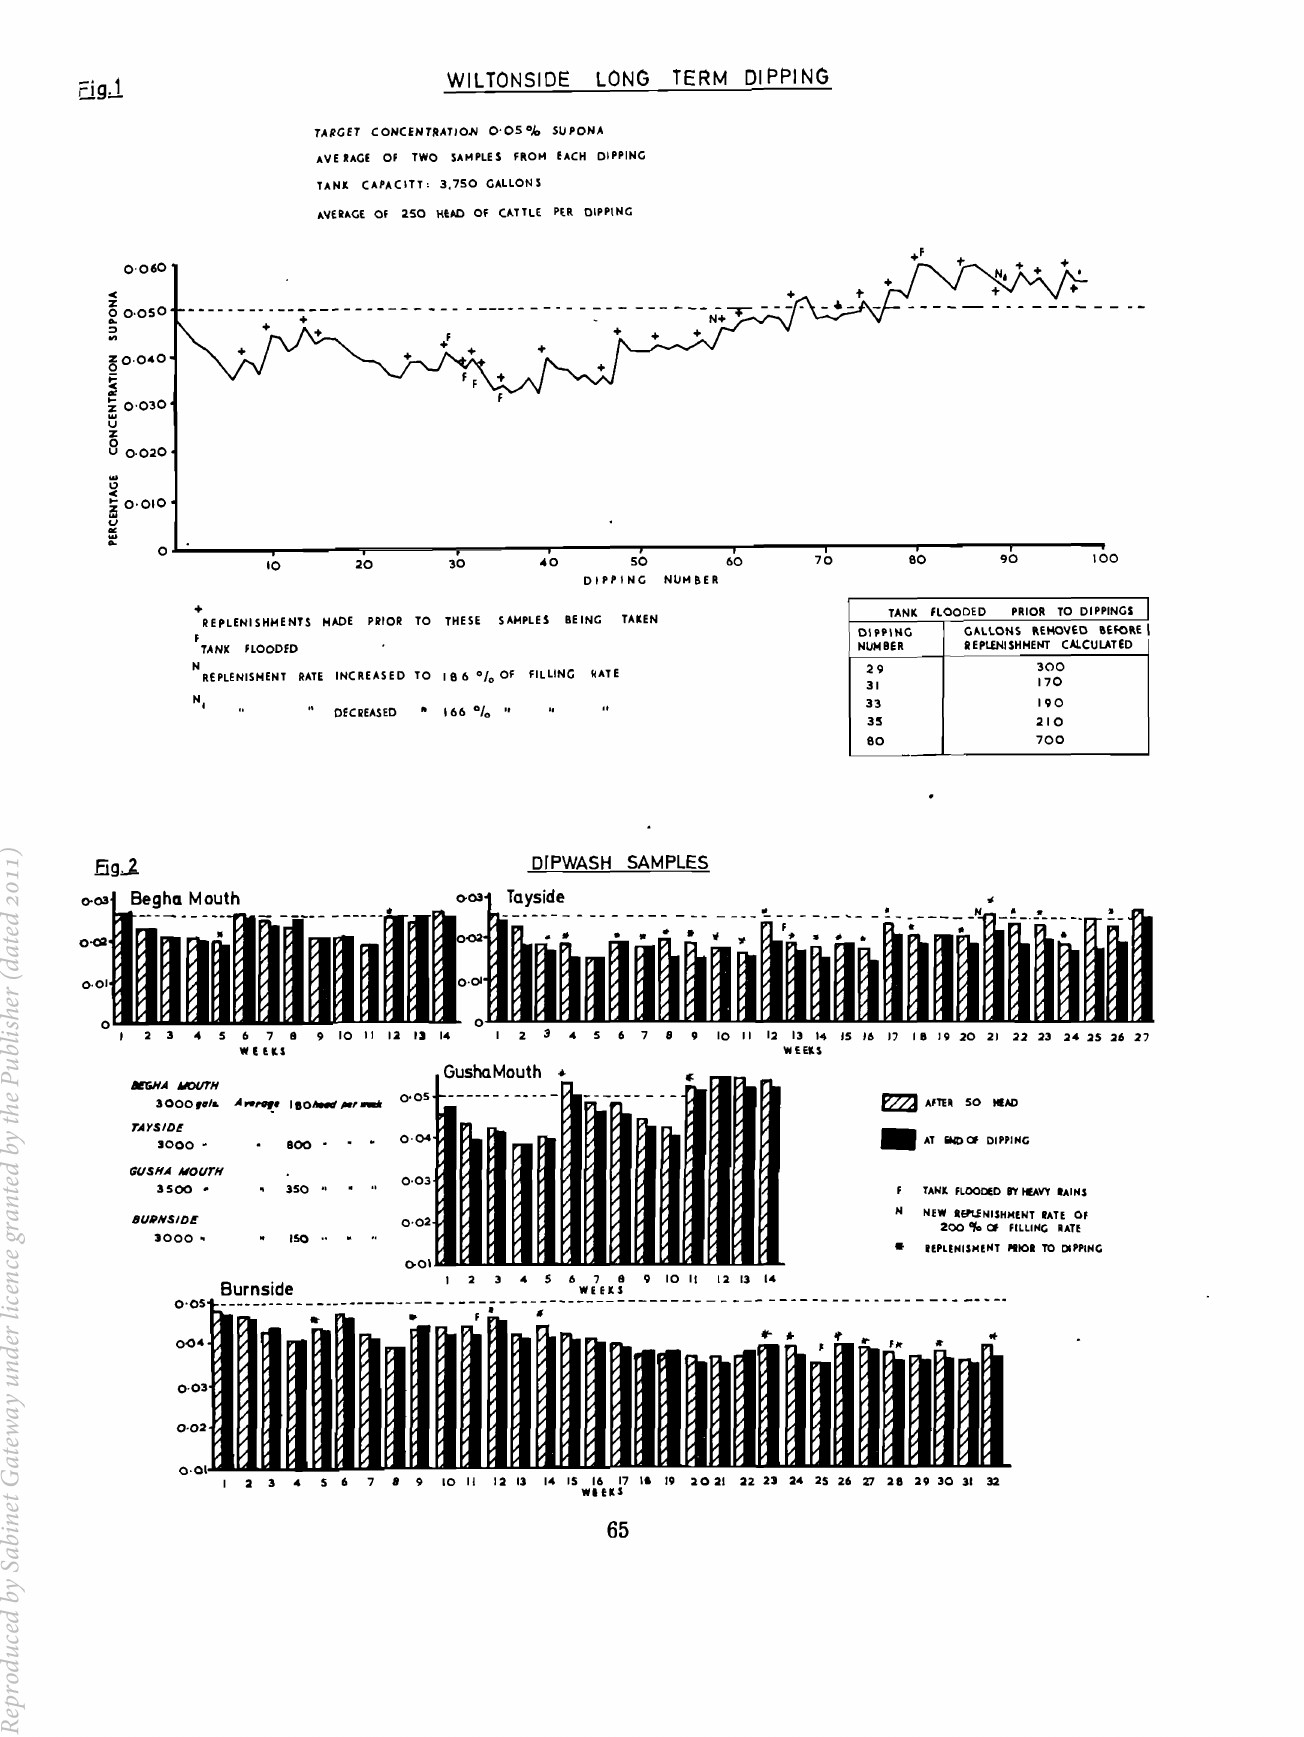
+ Il:EPLENISHMENTS HADE PilOIl TO THESE SAMPLES BEING TAltEN , TANK flOODED N REPLENISHENT RATE INCREASED TO 186 °/0 OF FILLING NATE